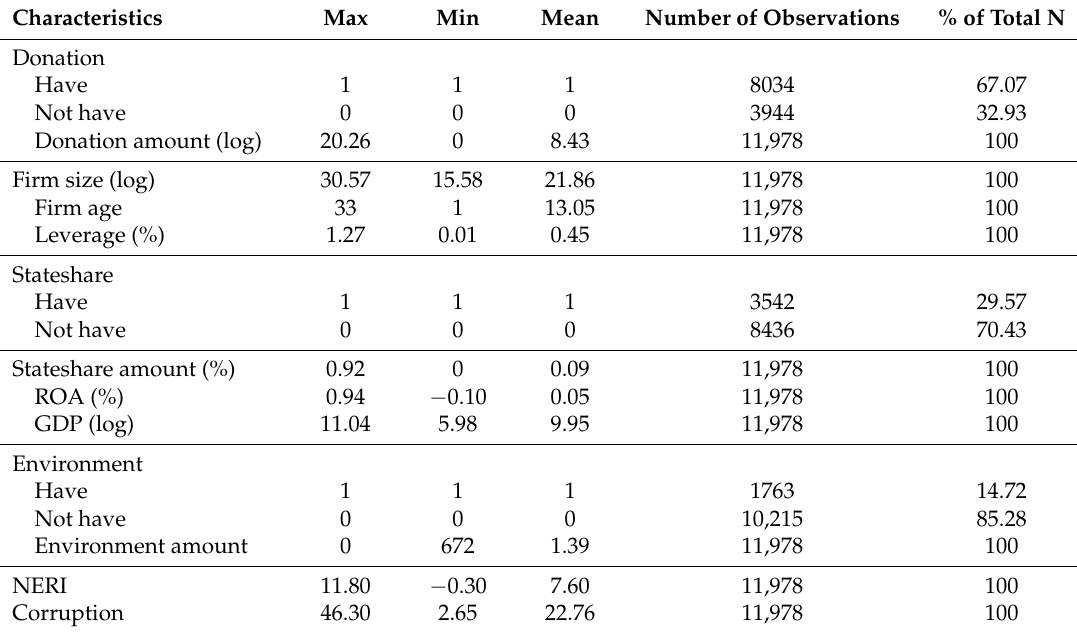
Table 1. Characteristics of the sample.